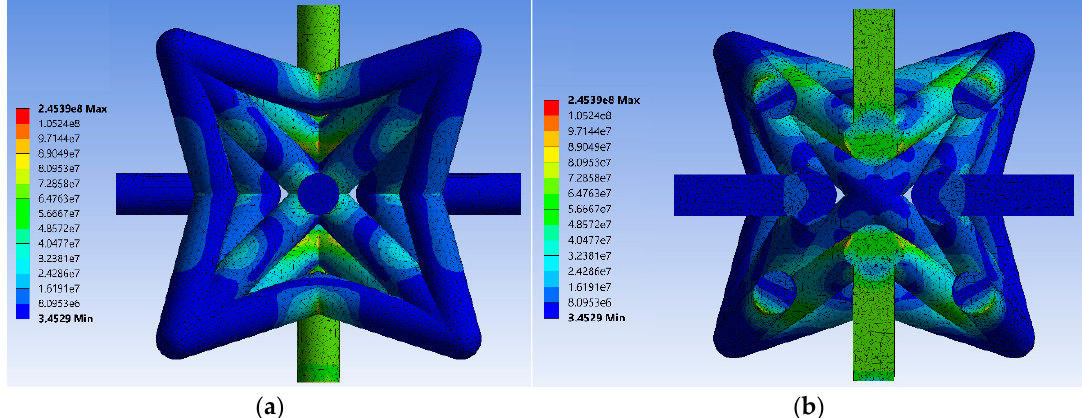
Figure 11. Von Mises equivalent stress for finite element (FE) model constructed by volumetric elements for µ = 0.2: ( a ) side view and ( b ) middle-section view of the unit cell. Von-Mises for all other relative densities are shown in Figures S25–S27.